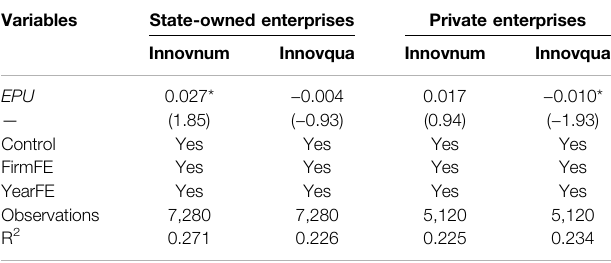
TABLE 5 | Heterogeneity of fi rm